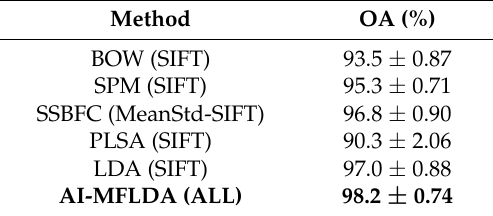
Table 1. Classification accuracy values (%) of the different methods with the four-class aurora image set.